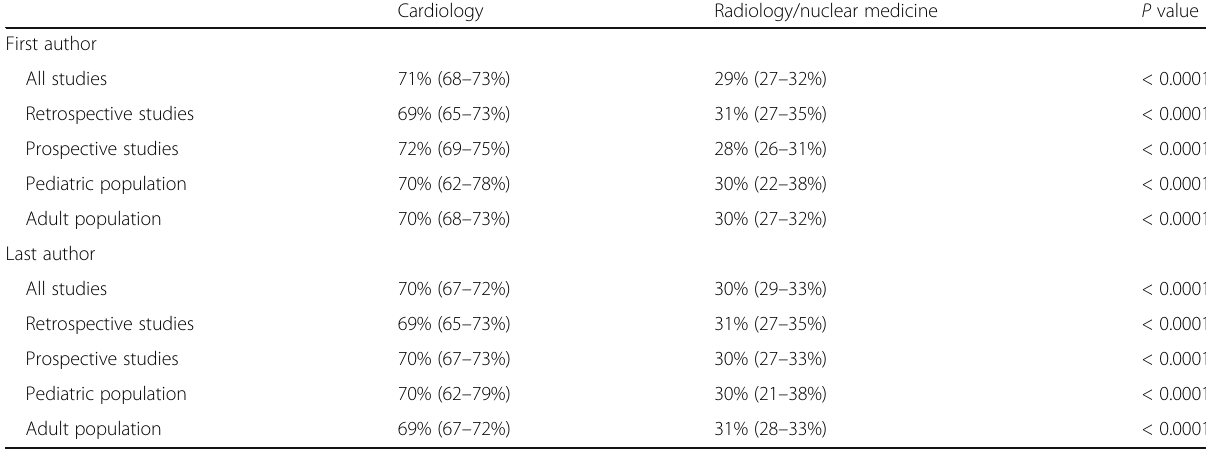
Table 1 Overall authorship proportions by study sub-categories for articles published by cardiologists or